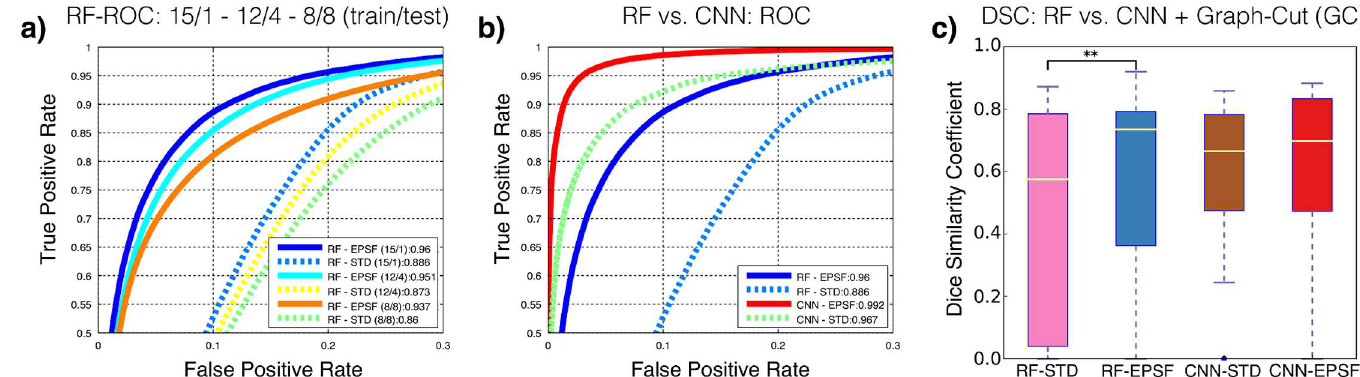
Fig 4. Classification performance. (a) ROC curve depictingthe effect of varyingamounts of (training/test) data for RF classificationwith and without EPSF. (b) ROC curve for both experiments (CNN / RF) with STD and with EPSF. (c) DSC tumor segmentation results for STD vs. EPSF. The latter shows better results for both cases ( ** = p <